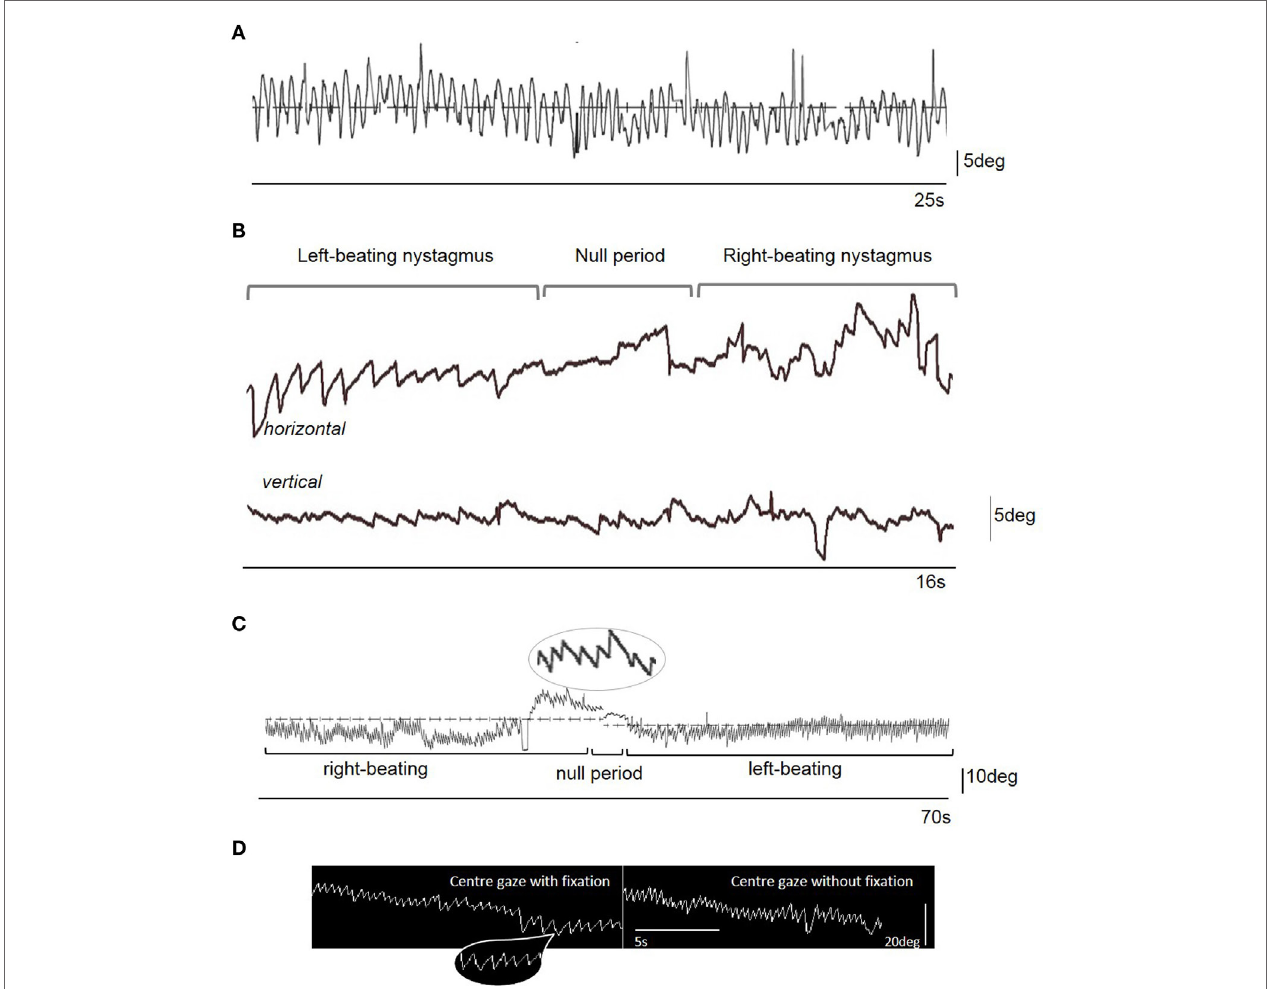
FIgURe 1 | (a) Videonystagmographic trace with the patient looking at a fixed central target straight ahead in the light, with the head free taken on Day 13 from symptom onset. Note the sinusoidal eye oscillations representing a compensatory movement to the head oscillations (i.e., a sinusoidal vestibulo-ocular reflex). There is no clear nystagmus evident on the trace (nor on clinical examination). (B) Videonystagmographic trace showing periodic alternating nystagmus on day 21 from symptom onset: left-beating predominantly horizontal nystagmus, a null period with no horizontal nystagmus, but prominent vertical (upbeat) nystagmus, followed by a reversal of the horizontal nystagmus into right-beating, with some attenuation of the vertical nystagmus. In central gaze, the left-beating nystagmus peak slow phase eye movement velocity (SPV) was 22°/s, and right-beating SPV was 34°/s. There was upbeat nystagmus starting 5 s prior to the change in nystagmus direction, with a SPV of 10°/s. Upward deflection represents rightward (for horizontal trace), and upward (for vertical trace) eye movements. (C) A 70 s videonystagmographic recording of the horizontal eye movements showing a longer period of alternating nystagmus with the eyes in the primary position, without fixation. (D) Electronystagmographic recordings in central gaze in the light (with fixation) and the dark (without fixation). Note the mostly linear or decreasing exponential velocity waveform of the nystagmus slow phase [insets in parts (C,D) ] that is more suggestive of an acquired nystagmus (1). Indeed, no clear congenital-type waveforms were seen in the traces.